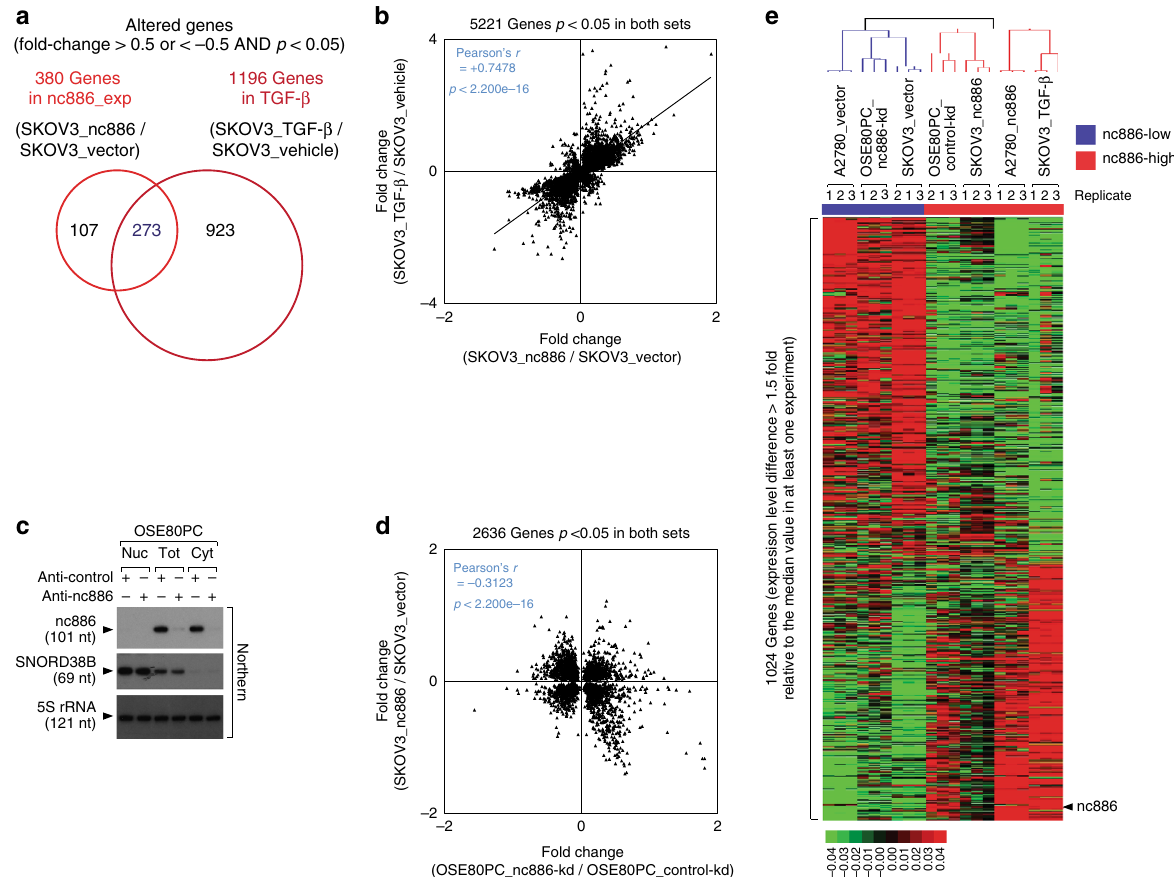
Fig. 3 nc886 emulates TGF- β in controlling gene expression. a A Venn diagram depicting the number of signi fi cantly altered genes upon ectopic expression of nc886 ( “ nc886_exp ” ) and in TGF- β treatment ( “ TGF- β ” ). The fc values are in log2 scale. See fi gure captions for details. b A scatter plot comparing fc values of 5221 genes altered by nc886 ( x -axis) and TGF- β ( y -axis). c Northern hybridization of nc886, SNORD38B as a nuclear marker, and 5S rRNA as a loading control. OSE80PC cells were transfected with an nc886-targeting anti-oligo ( “ anti-nc886 ” ) or with a non-targeting anti-oligo ( “ anti-control ” ) at 100 nM. Cells were harvested for nuclear and cytoplasmic fractionation at 48 h post transfection. d A scatter plot comparing nc886-kd and nc886 expression, as described in ( b ). e A heat map showing the unsupervised hierarchical clustering of 1024 genes (see fi gure caption for the selection criterion). Their expression levels, which are array values relative to the median value across samples, are displayed as green to red (see the color bar below the map for scale). Seven experiments, each of which was triplicated, are partitioned into two groups: nc886-low and nc886-high (respectively blue bar and red bar on the top) which are consistent with nc886 levels expected from experimental manipulation (nc886 kd or ectopic expression and TGF- β treatment). The blue and red color signature (for nc886-low and – high respectively) was used throughout all bar graphs and